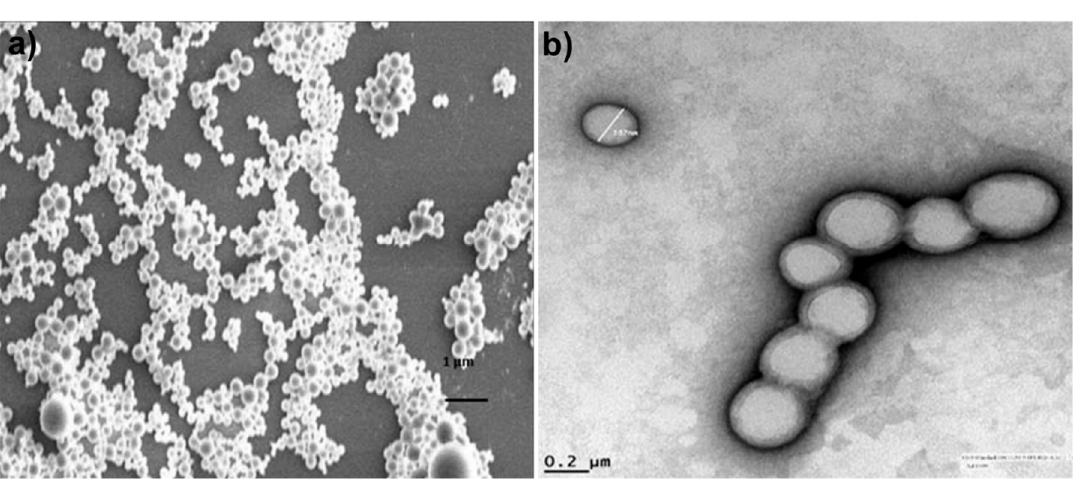
Figure 5. ( a ) Scanning electron microscope (SEM) and ( b ) transmission electron microscope (TEM) images of TQ/PLGA nanoparticles formulated with single emulsion solvent evaporation method. Reprinted with permission from Ref. [18].